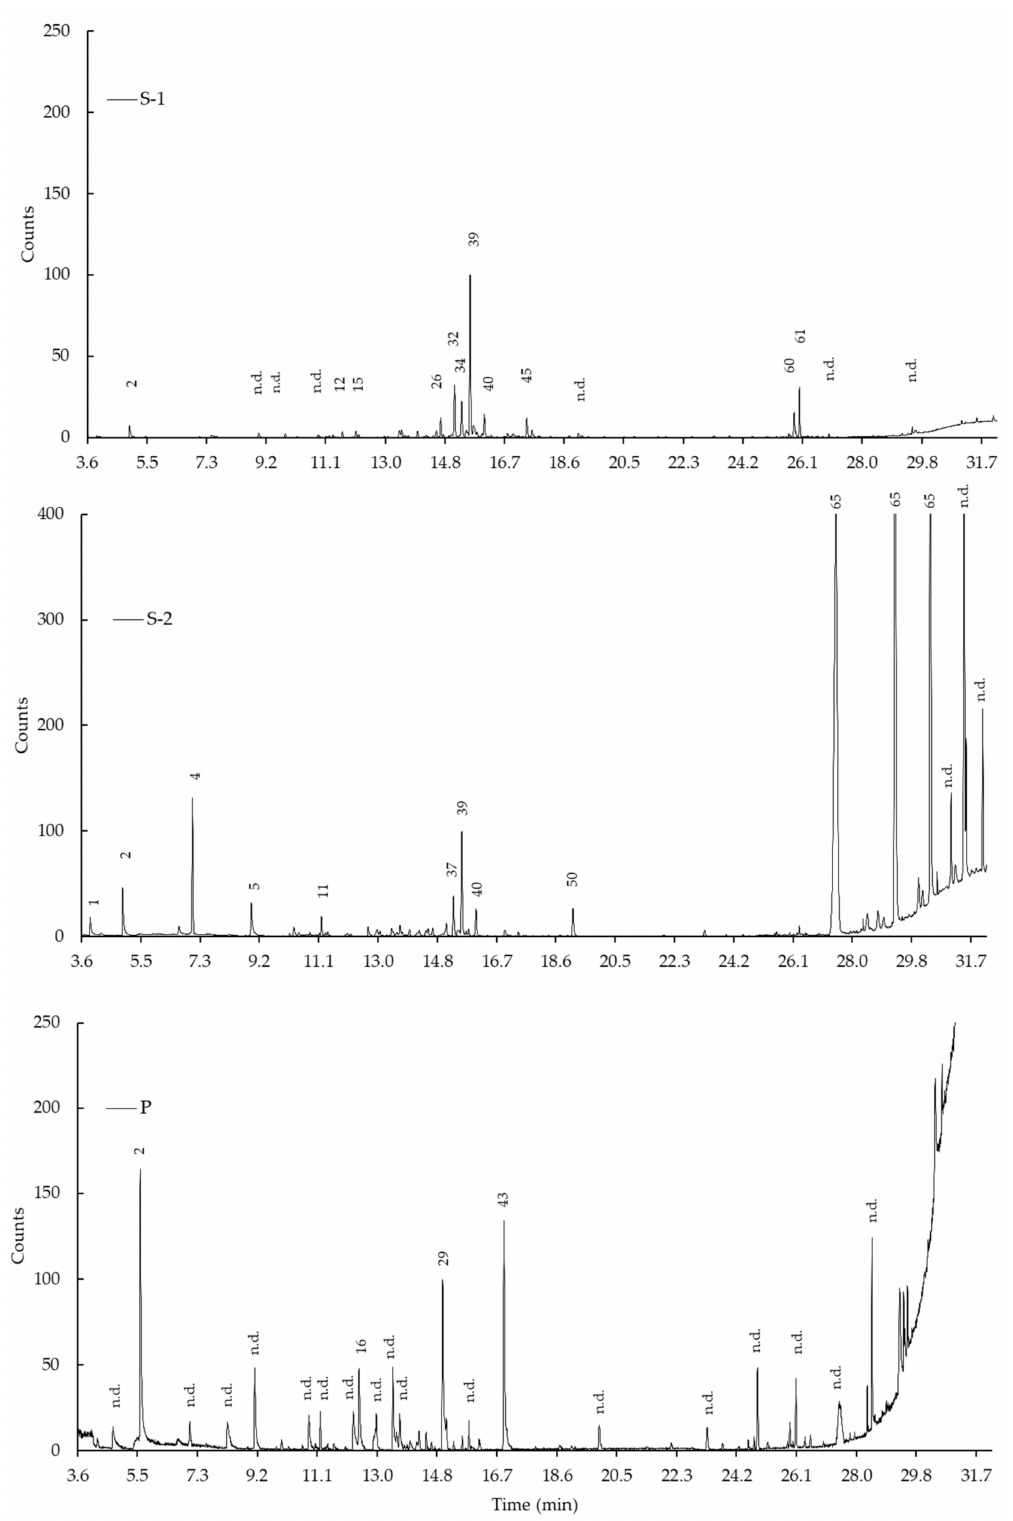
Figure 2. Chemical compounds measured by gas chromatography–mass spectrometry (GC–MS) for spruce-based (S-1 and S-2) and poplar-based (P) press waters. Detected chemical compounds were labeled with numbers. Compounds that could not be identified by the GC–MS system were labeled as not detected (n.d.). Further information on the chemical compounds can be found in Table